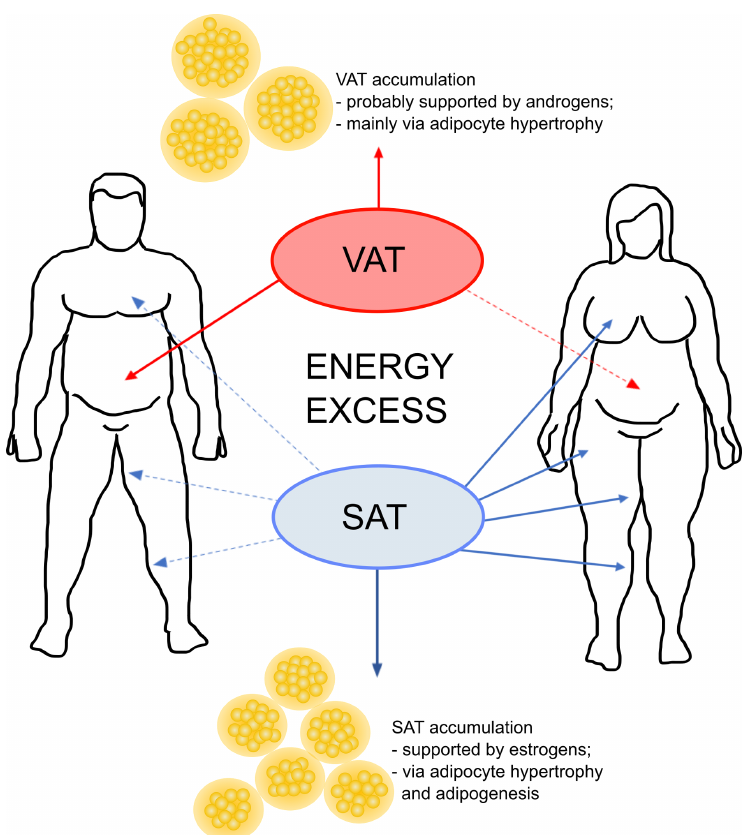
Figure 3. Schematic representation of sex-dependent differences in the fat deposition patterns. The visceral adipose tissue (VAT) is located around the abdominal organs and is the main type of fat depots in men. On the contrary, women distribute fat mostly in the form of subcutaneous fat. In general, increased visceral mass predominantly results from adipocyte hypertrophy, whereas subcu- taneous fat (SAT) grows through both hypertrophy and hyperplasia (with prevailing hyperplastic mechanism) [77,78]. Considering sex-dependent differences in growth of gonadal fat depots, it is observed that, in response to energy excess, male gonadal depot grows mainly through hypertrophy, while female gonadal depots expand both hypertrophy and hyperplasia